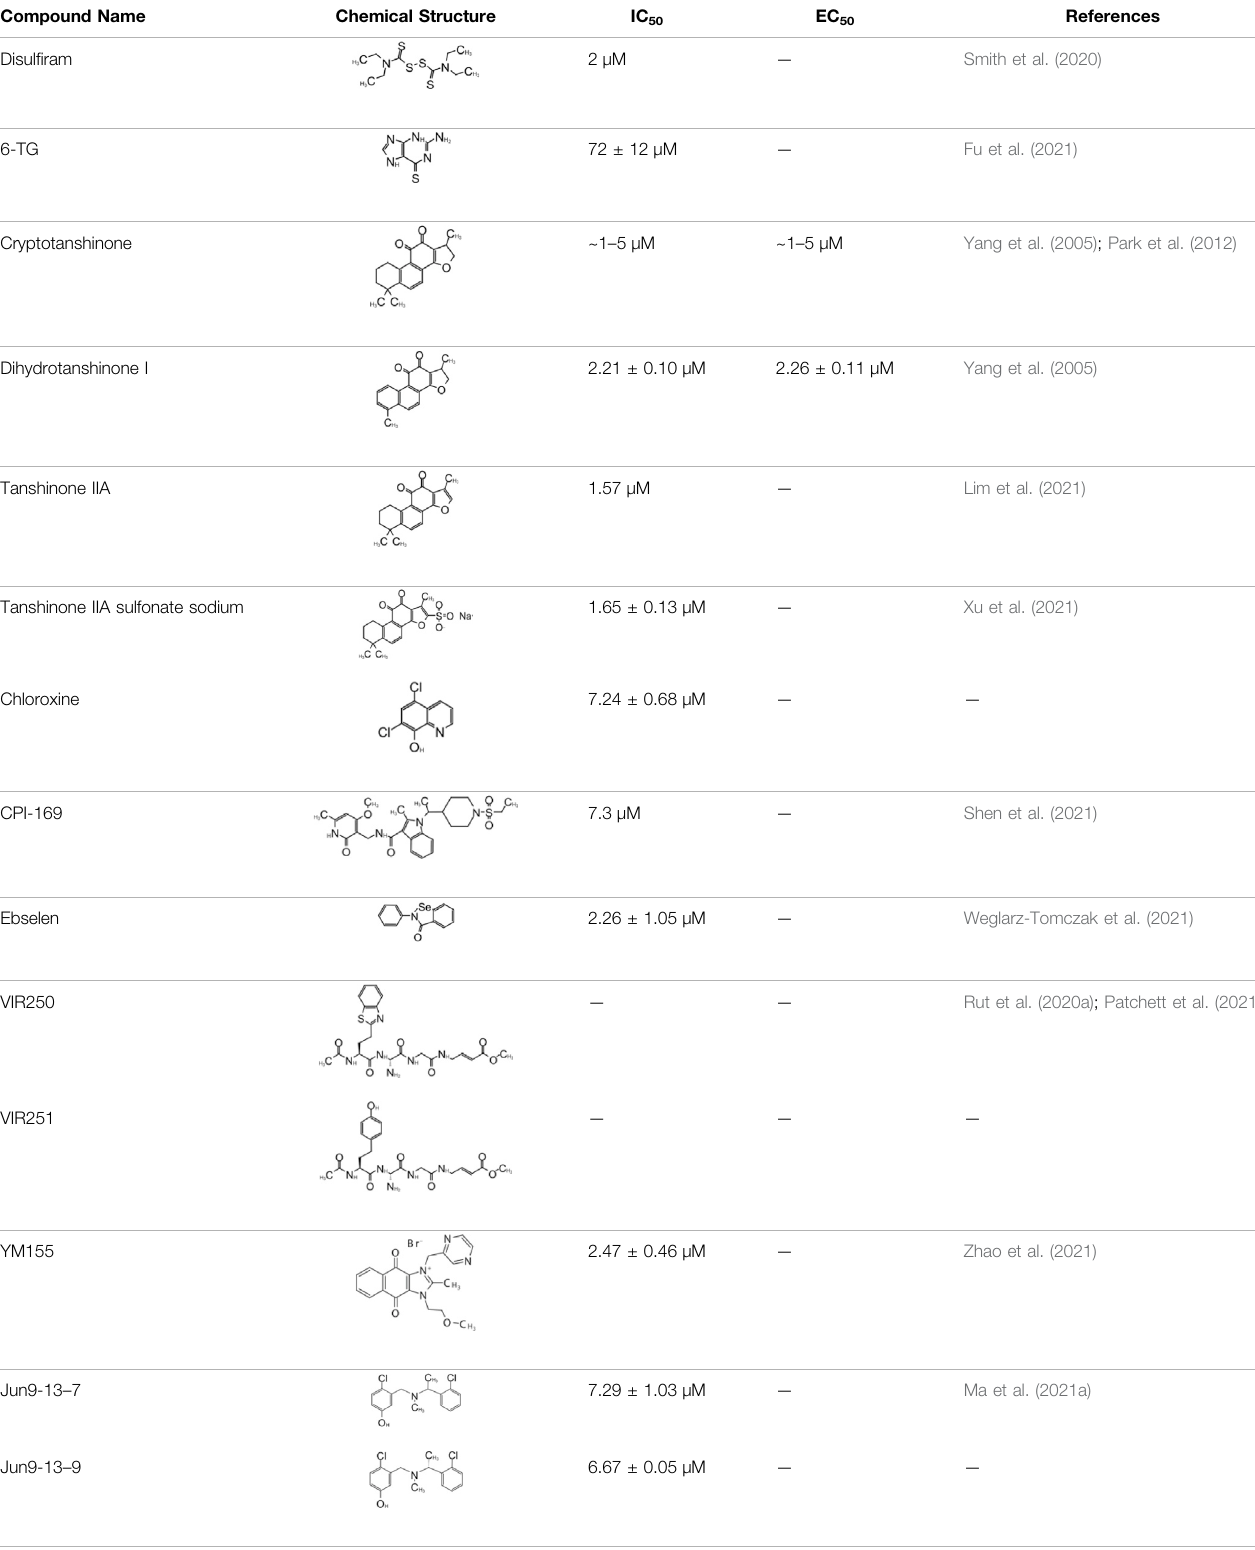
TABLE 3 | Other PLpro